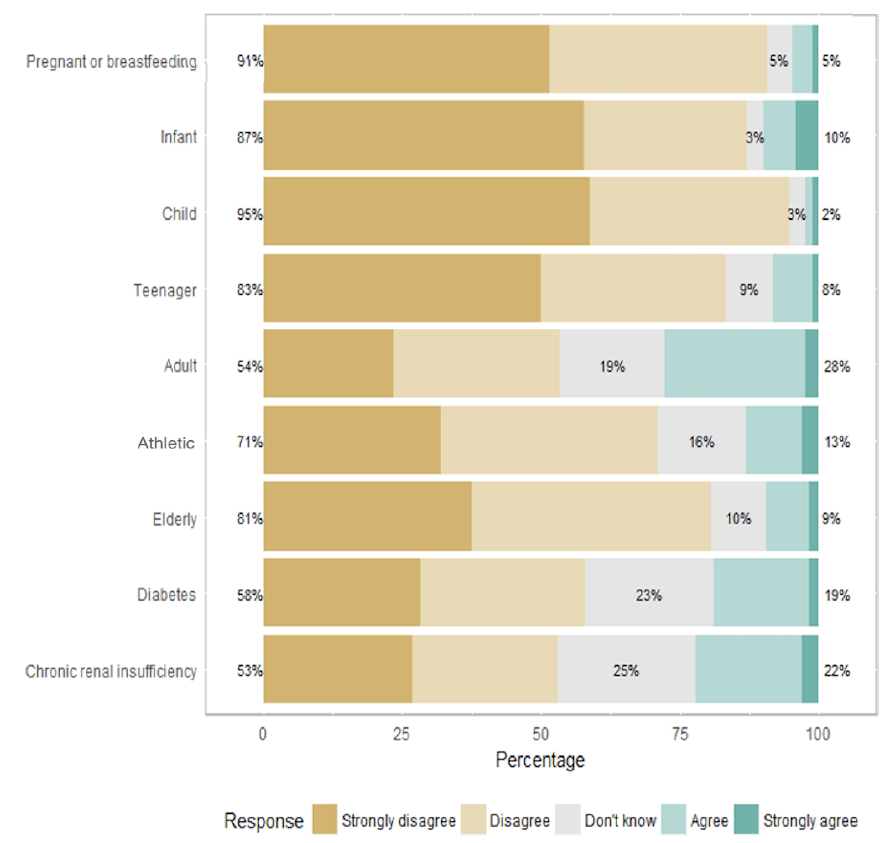
Figure 3. Ovo-lacto-vegetarian diet’s suitability, depending on different populations.